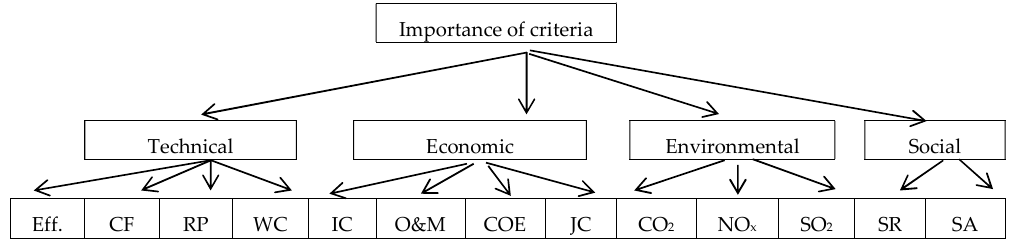
Figure 8. Illustrative scheme of the AHP network ( IC: Investment cost; O&M: operation and maintenance costs; COE: Cost of electricity; JC: Job creation; SR: Safety risks; SA: Social acceptability; Eff.: Efficiency of power generation; CF: Capacity factor; RP: Resource potential; WC: Water consumption; CO 2 , NO x , SO 2 gas emissions ) . Table 6. Scoring scale of AHP and its interpretation [12].